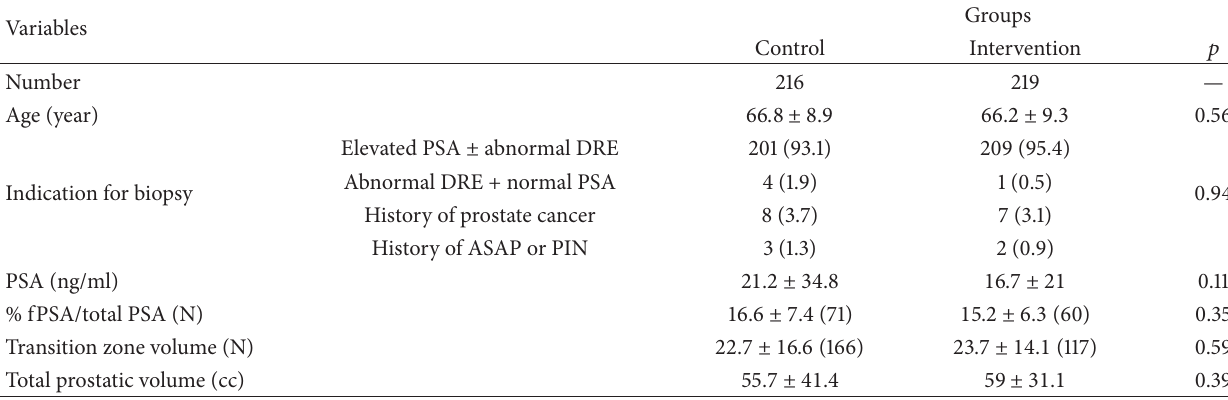
Table 1: Distribution of basic and prostate variables in both groups.